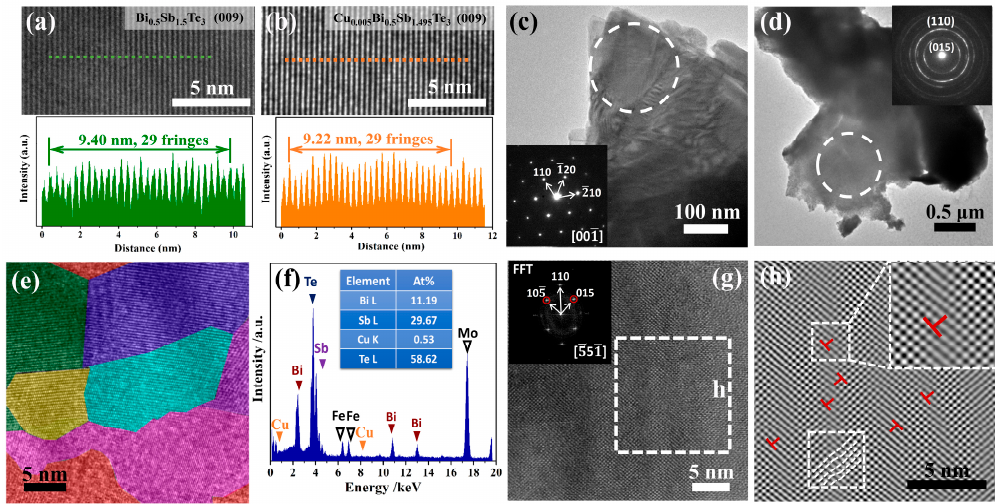
Figure 2. The total distances of 29 fringes in the regular (009) plane TEM images for ( a ) Bi 0.5 Sb 1.5 Te 3 and ( b ) Cu 0.005 Bi 0.5 Sb 1.495 Te 3 . Low-magnification TEM images for ( c ) Bi 0.5 Sb 1.5 Te 3 matrix and ( d ) Cu 0.005 Bi 0.5 Sb 1.495 Te 3 . The insets are the corresponding electron diffraction patterns obtained from the circumvented areas. ( e ) Nanograins with coherent grain boundaries in Cu 0.005 Bi 0.5 Sb 1.495 Te 3 ; ( f ) The energy dispersive spectrum (EDS) analysis on the circumvented area in Figure 2d. The signals of Mo and Fe are from Mo grids and sample stage; ( g ) HRTEM image of Cu 0.005 Bi 0.5 Sb 1.495 Te 3 . The inset shows the fast Fourier transferred (FFT) image; ( h ) Inverse fast Fourier transferred (IFFT) image of planes (015) and (10 5(cid:3364) ) in the marked square region in Figure 2g, in which lots of lattice distortions and edge dislocations are observed.